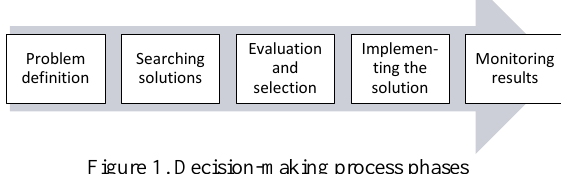
Figure 1. Decision-making process phases